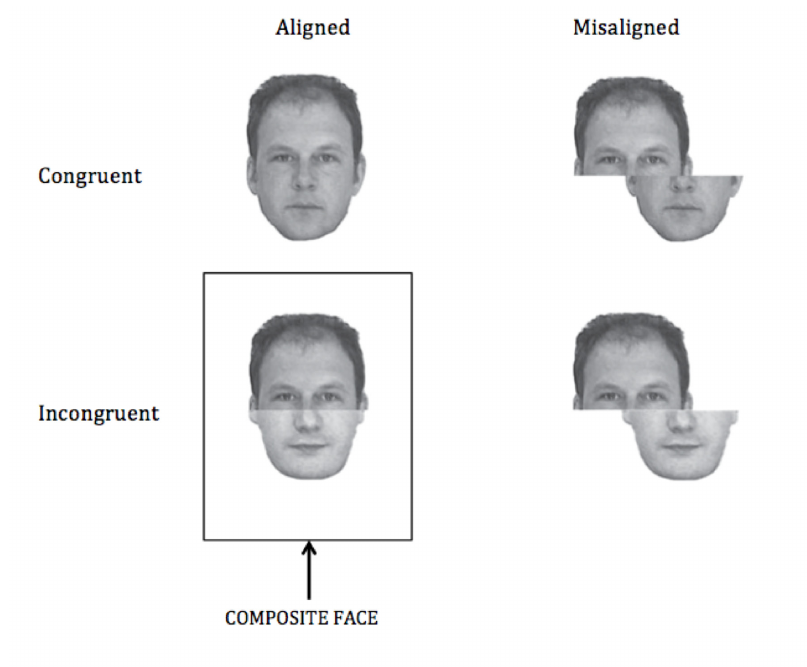
Figure 1. Examples of the four stimulus types (adapted from Weston and Perfect 30 ). Stimuli for the task used in the present study took the same form as these examples, but were created from black-and-white publicity photographs of two well-known movie stars (Brad Pitt and George